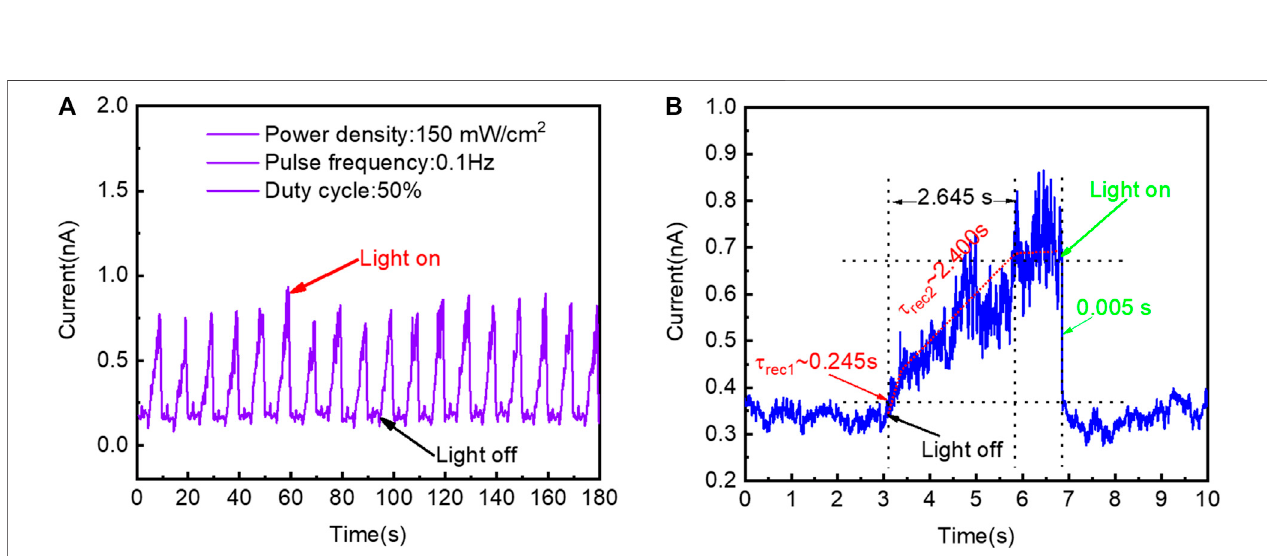
FIGURE 4 | (A) Photoresponse of the NW photodetector under an illumination intensity of 150 mW/cm 2 . The chopped pulse frequency is 0.1 Hz, and the duty cycle is 50%. (B) A high-resolution transient photoresponse of the device to a pulse incidence.